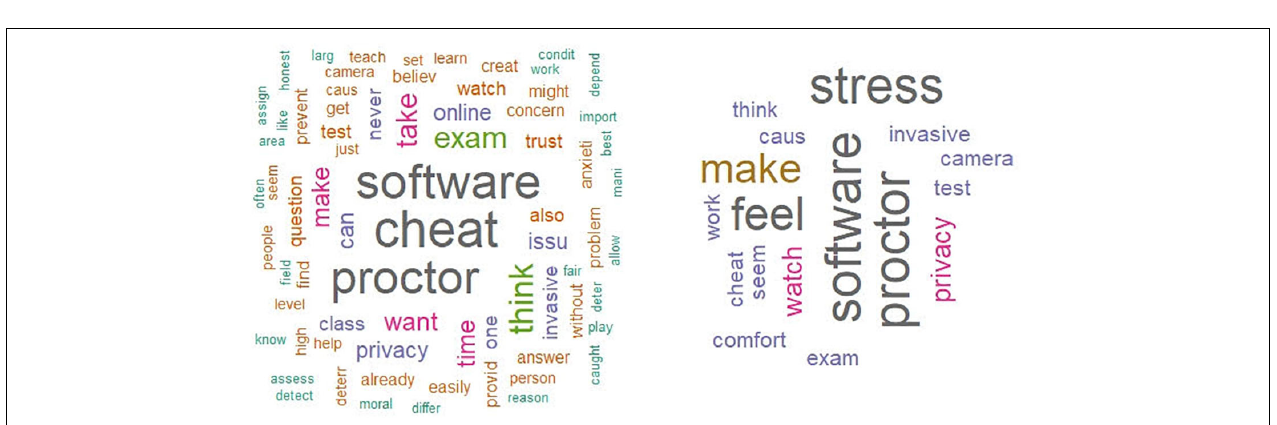
FIGURE 4 | Faculty and student responses to: How important is it to you that a Department or University policy is in place for proctoring online tests that are given outside of a traditional classroom setting?